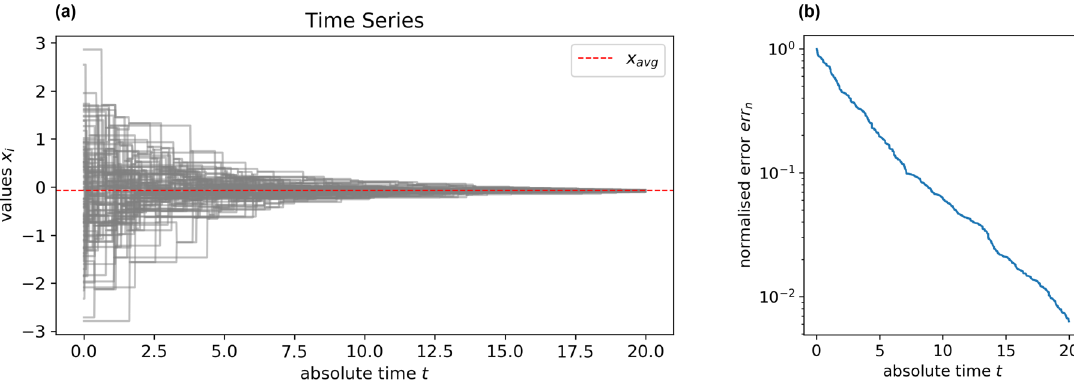
Figure 7. ( a ) Values x i evolving over time and converging to the average of the initial values x avg in a ER graph 100 and deg 5 with ( b ) the corresponding normalised error err with n avg = =